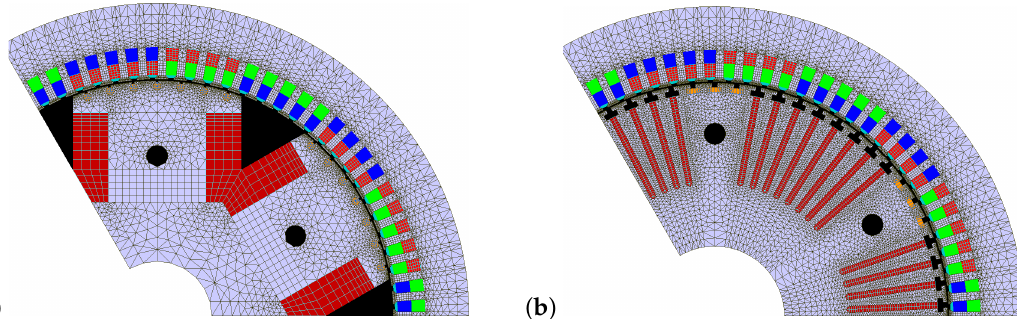
Figure 6. FEM model mesh of the: ( a ) commercial salient pole field BSG; ( b ) prototype cylindrical field BSG.